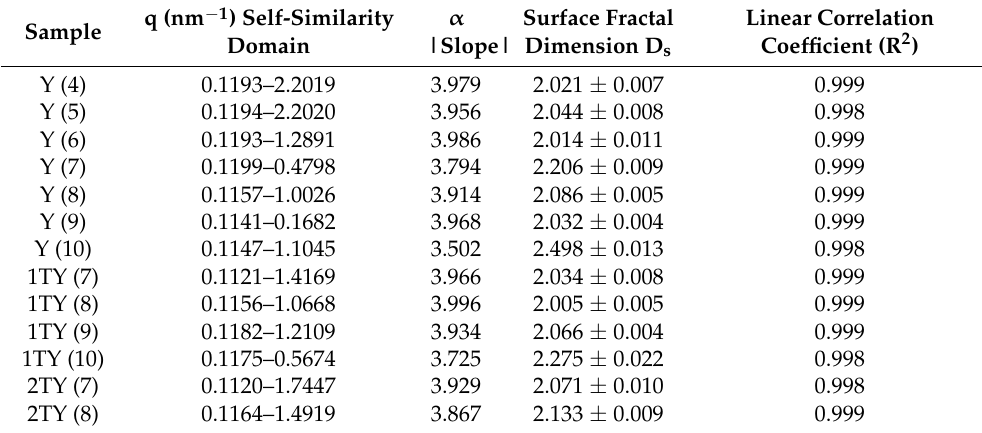
Table 1. Surface fractal properties for Y, 1TY (1% TiO 2 ), and 2TY (2% TiO 2 ) systems in different stages of the zeolitization